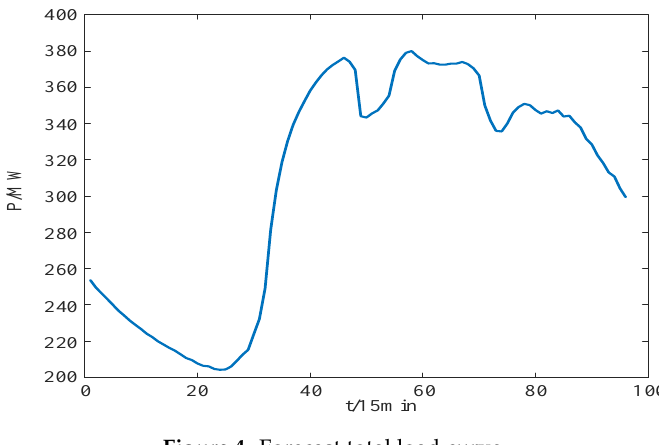
Figure 4. Forecast total load curve. Table 1. Power value of each phase of the load buses (kW, kvar).